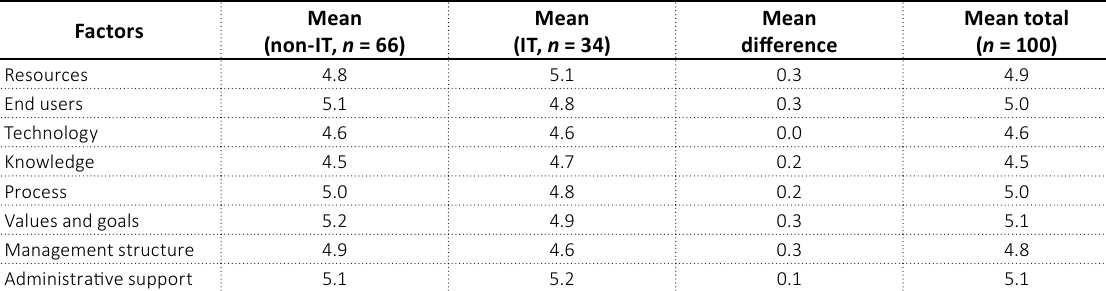
Table 12. Analysis of mean internal readiness